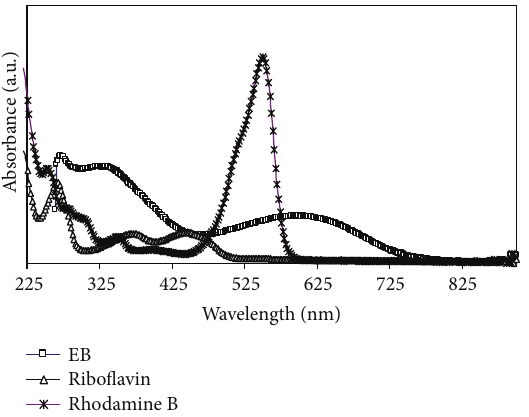
Figure 1: UV-visible spectra of EB, riboflavin, and rodamine B dyes.